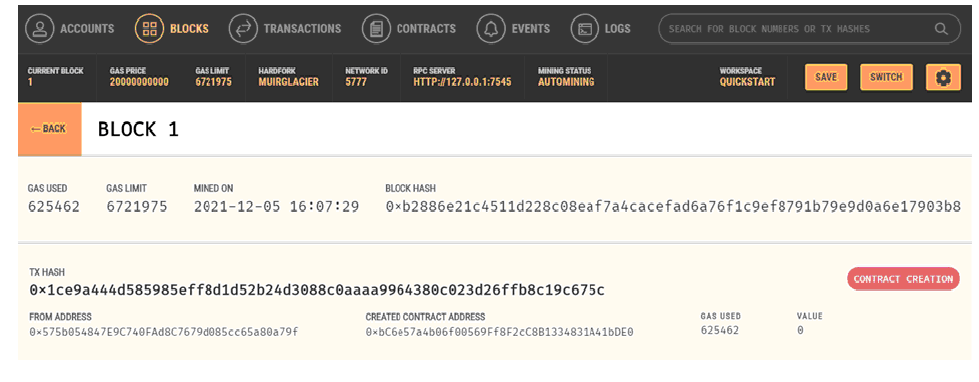
Figure 13. Block 1 obtained result.